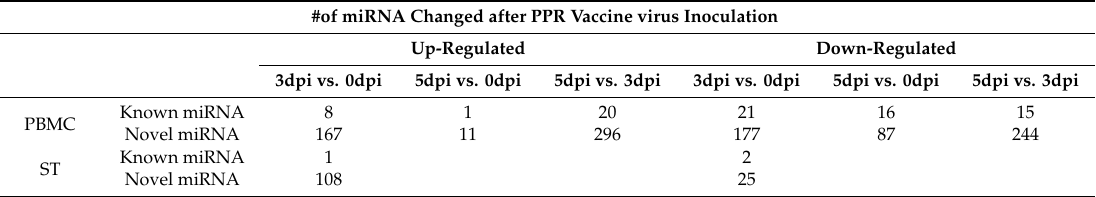
Table 2. Up / down-regulated miRNAs in sheep PBMC and ST cells.